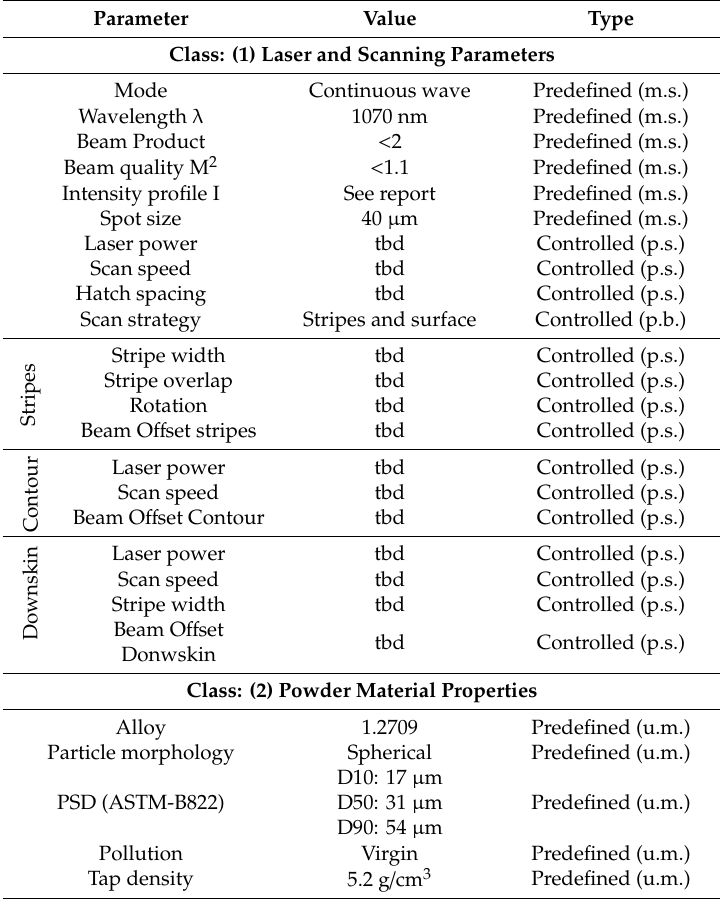
Table 2. Example for the definition of process parameters for MS1 ( t = 30 µ m). Classifications based on [4,6,7]. p.s. = “per specimen”; p.b. = “per build”; m.s. = “machine setup; u.m. = “used material”; tbd = “to be defined”; PSD = “particle size